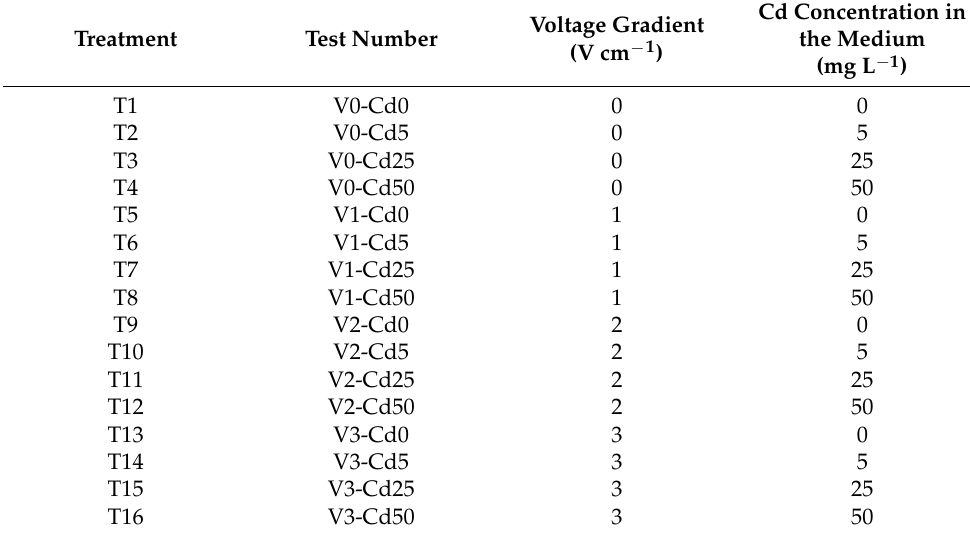
Figure 1. The electrical setting of the experiment. Table 1. Various experimental treatments.